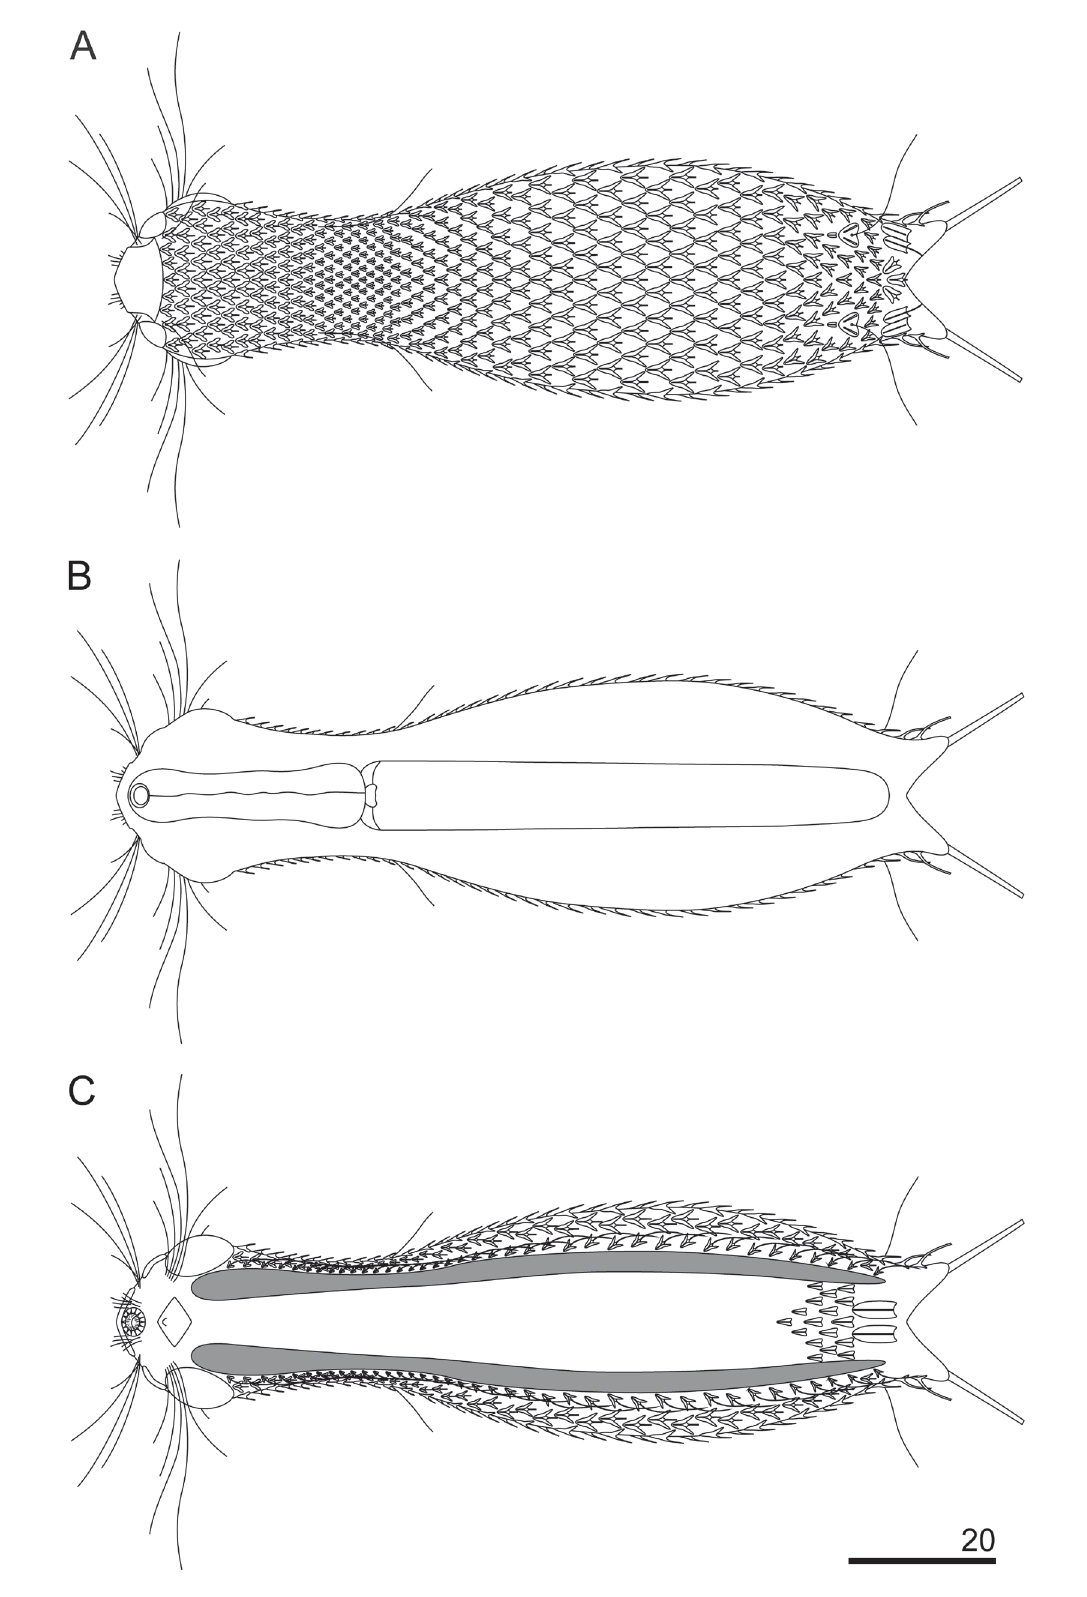
Fig. 4. Chaetonotus (Chaetonotus) antrumus Kolicka sp. nov., schematic drawings. A . Dorsal body view. B . Internal body view. C . Ventral body